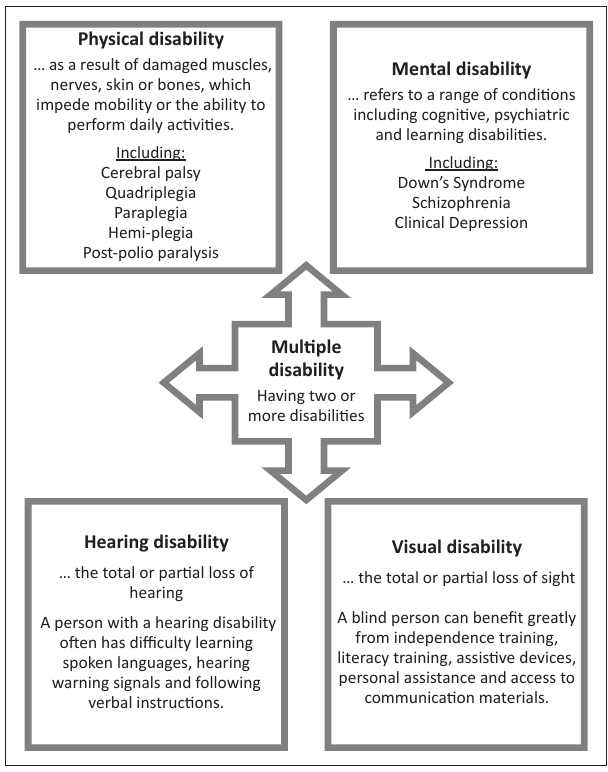
FIGURE 1: Categories of